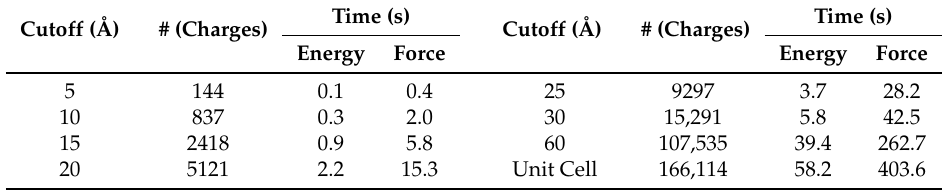
Table 1. Number of near-field MM charges and CPU time (in seconds) for QM/MM electrostatic energy and force evaluations at different cutoff distances. The QM region is the oxyluciferin anion, which is described by the B3LYP/6-31+G* level of theory. The MM region is a 117Å × 117Å × 117Å unit cell